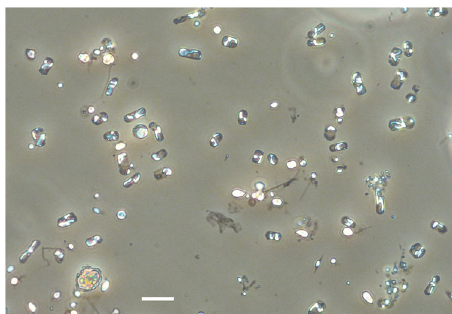
Fig. 4 Minidiscus spp. in light microscopy. The dominating nano-sized Minidiscus centric diatoms (2 – 5 µ m diameter) seen in light microscopy at station 74 (5.8 million cells L − 1 ) showing the impossibility of identifying it with the latter technique, while it remains possible to count it and compare with parallel SEM identi fi cation. The yellow Lugol stain background was removed using the camera ’ s autowhite function. The scale bar is 10 µ m